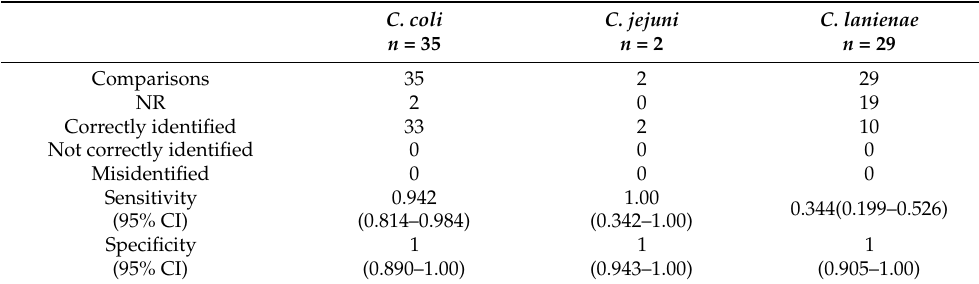
Table 5. MALDI-TOF identification results of tested Campylobacter isolates ( n = 66) (with genotypic identification taken to be